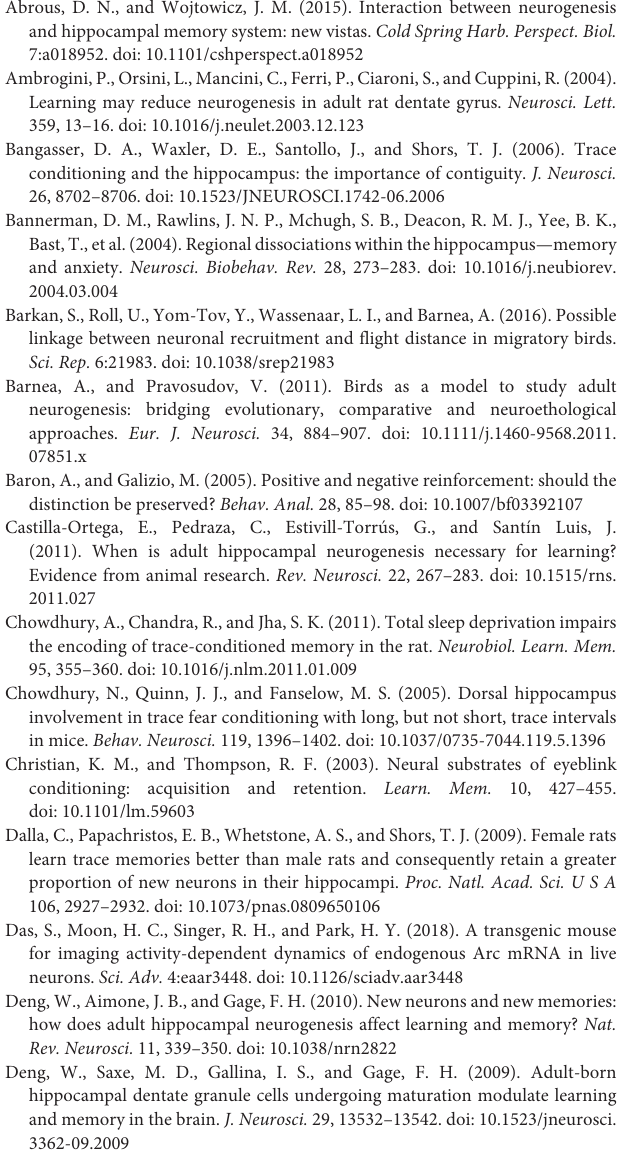
FIGURE S1 | The changes in the number of BrdU +ve and Ki67 +ve double-labeled cells in the DG area in the delay- and trace-conditioned animals ( n = 9). (A) Photomicrographs of DG area showing BrdU +ve , Ki67 +ve , and BrdU +ve and Ki67 +ve double-labeled cells in un-conditioned, delay-conditioned, and trace-conditioned animals (10 × magnification). Green dots show BrdU +ve , red dots show Ki67 +ve , and yellow and orange dots show BrdU +ve and Ki67 +ve double-labeled cells in the DG area of the hippocampus. Bar graphs showing the number of (B) BrdU +ve cells/mm 3 of DG, (C) Ki67 +ve cells/mm 3 of DG, and (D) BrdU +ve and Ki67 +ve double-labeled cells/mm 3 of DG in un-conditioned ( n = 3),